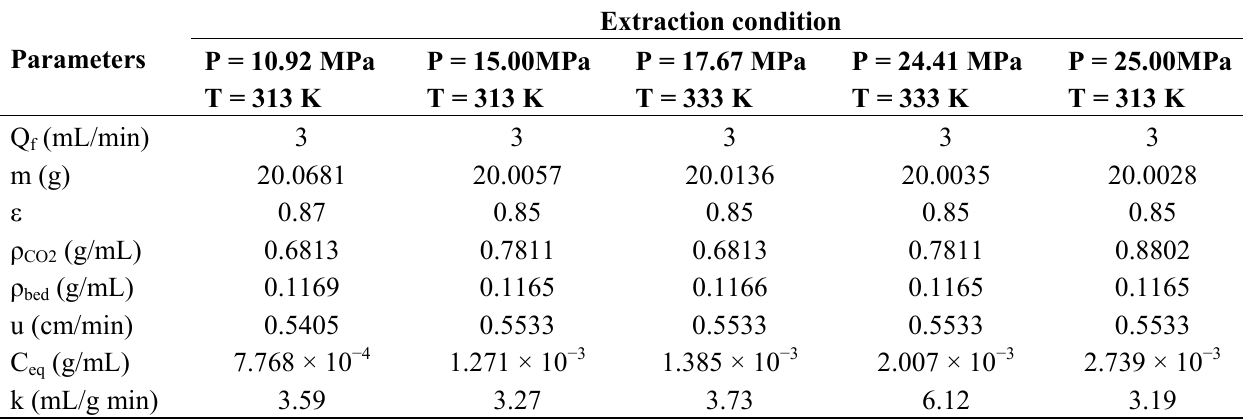
Table 5. Parameters of mass transfer and constant k for the mathematical modeling according to extraction conditions.